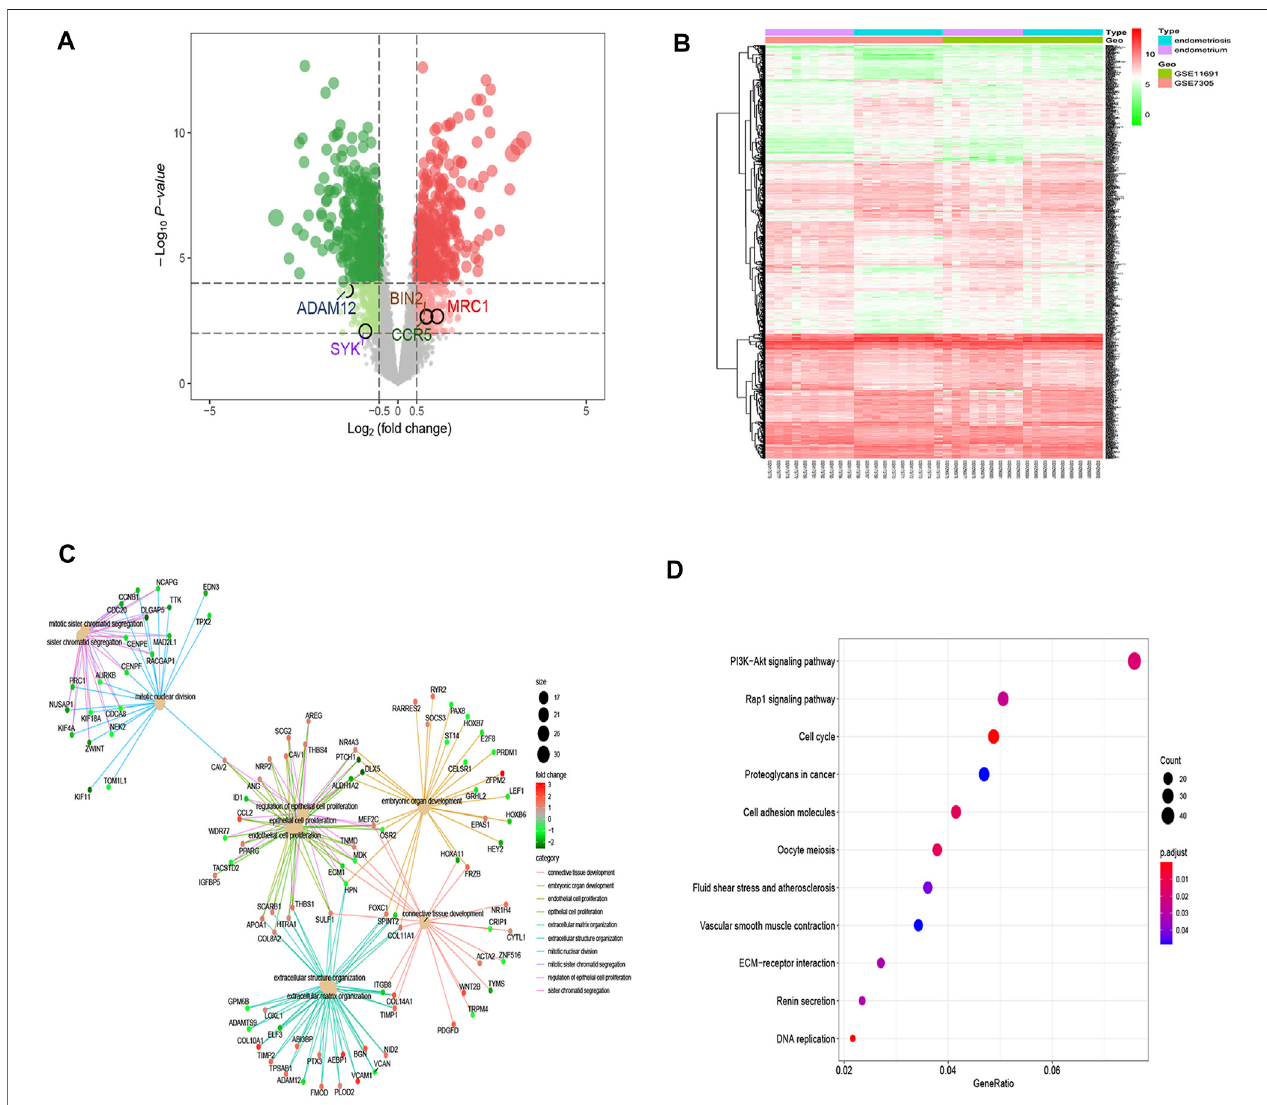
FIGURE 4 | DEGs enrichment analysis. (A) Volcano plots of DEGs between endometrium and endometriosis, where red dots indicate upregulated genes, green dotsindicatedownregulatedgenes,andgraydotsindicatenosubstantialdifference(|log2(foldchange)| > 0.5andcorrected p -values < 0.05). (B) Heatmapillustratingthe DEGsinboththeendometriumandendometriosissamples,whereredindicatessigni fi cantlyupregulatedgenes,greenindicatessigni fi cantlydownregulatedgenes,and whiteindicatesgeneswithnosubstantialdifference. (C) GOanalysisofDEGs.Thecenterdotsindicatethedifferentimportantbiologicalprocesses,andthesizesof the center dots re fl ect the number of genes involved in biological processes. The small dots that radiate from the central dot connected by lines with the same color represent those genes with the same biological function, and the colors of the small dots represent the fold change of the genes that they re fl ect. (D) KEGG pathway analysis of DEGs revealed the top 11 relevant pathways. The dot sizes refer to the number of genes involved in the pathway, and the dot colors depict the p -values.